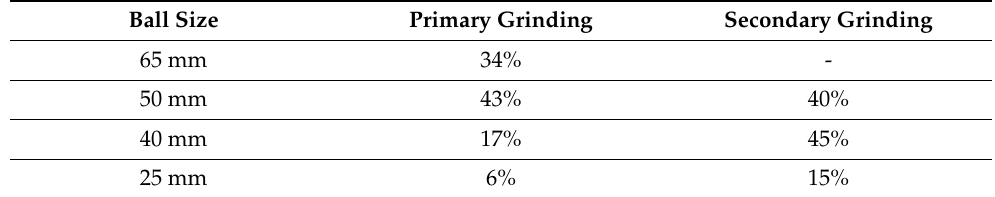
Table 2. Steel ball mass